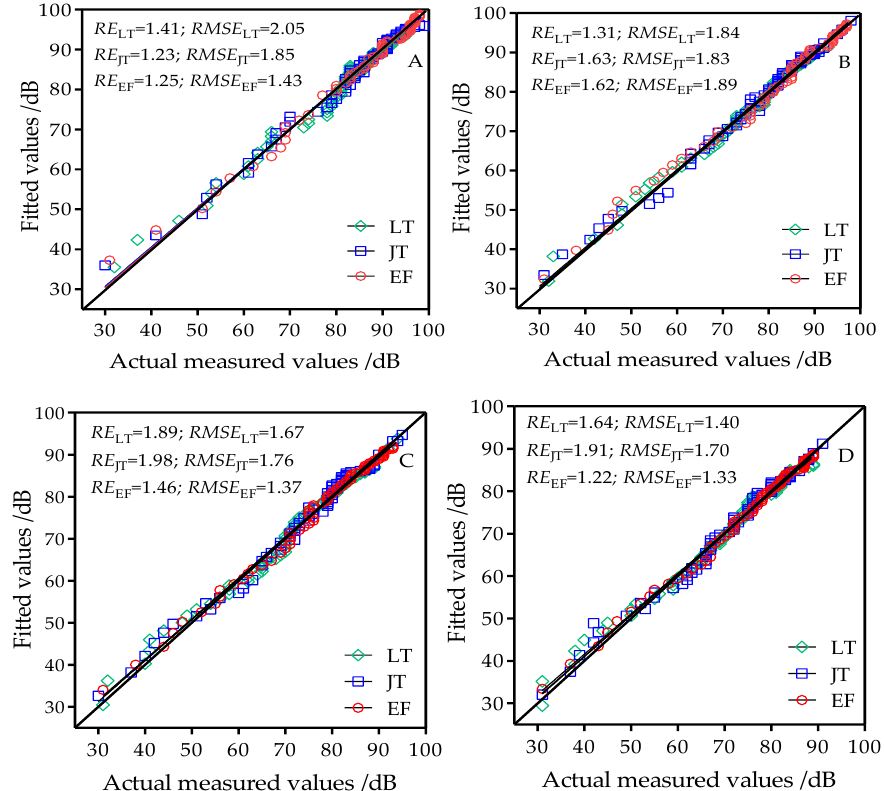
Figure 7. Comparison chart of fitted values from the modified two-slope log-distance model and actual measured values at antenna heights of ( A ) 0.8 m; ( B ) 1.2 m; ( C ) 1.6 m; and ( D ) 2.0 m; LT: tillering stage; JT: jointing stage; EF: grain filling stage.